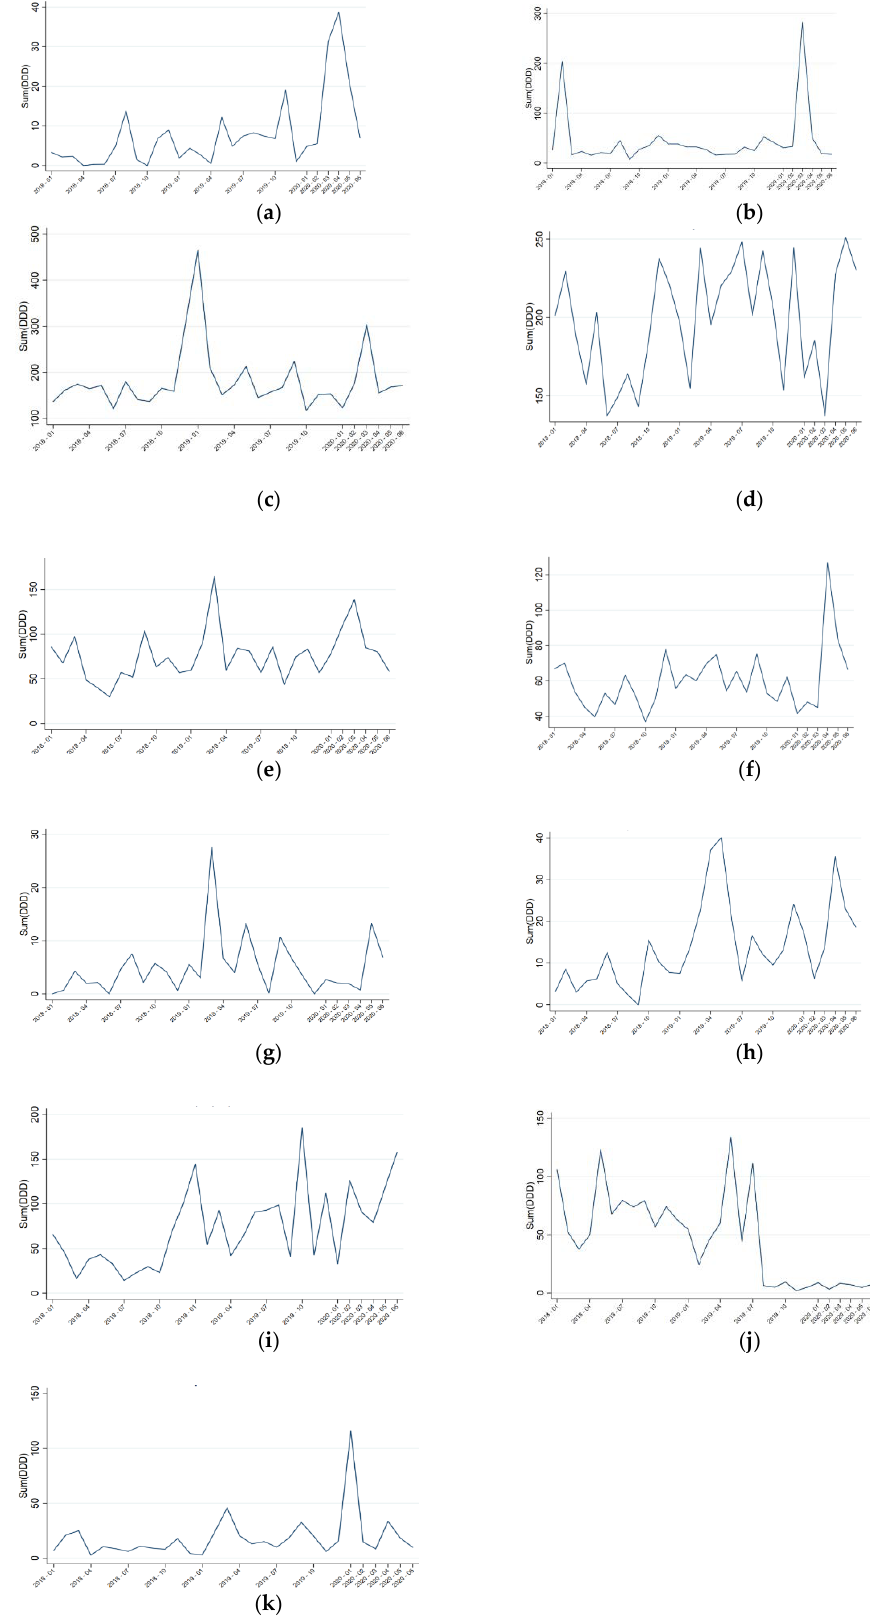
Figure 1. Evolution of drug consumption in hospital expressed in defined daily doses (DDD)/100 bed-days. ( a ) Ceftaroline: β -change 11.771, p = 0.014; ( b ) azithromycin: β -change 63.129, p =